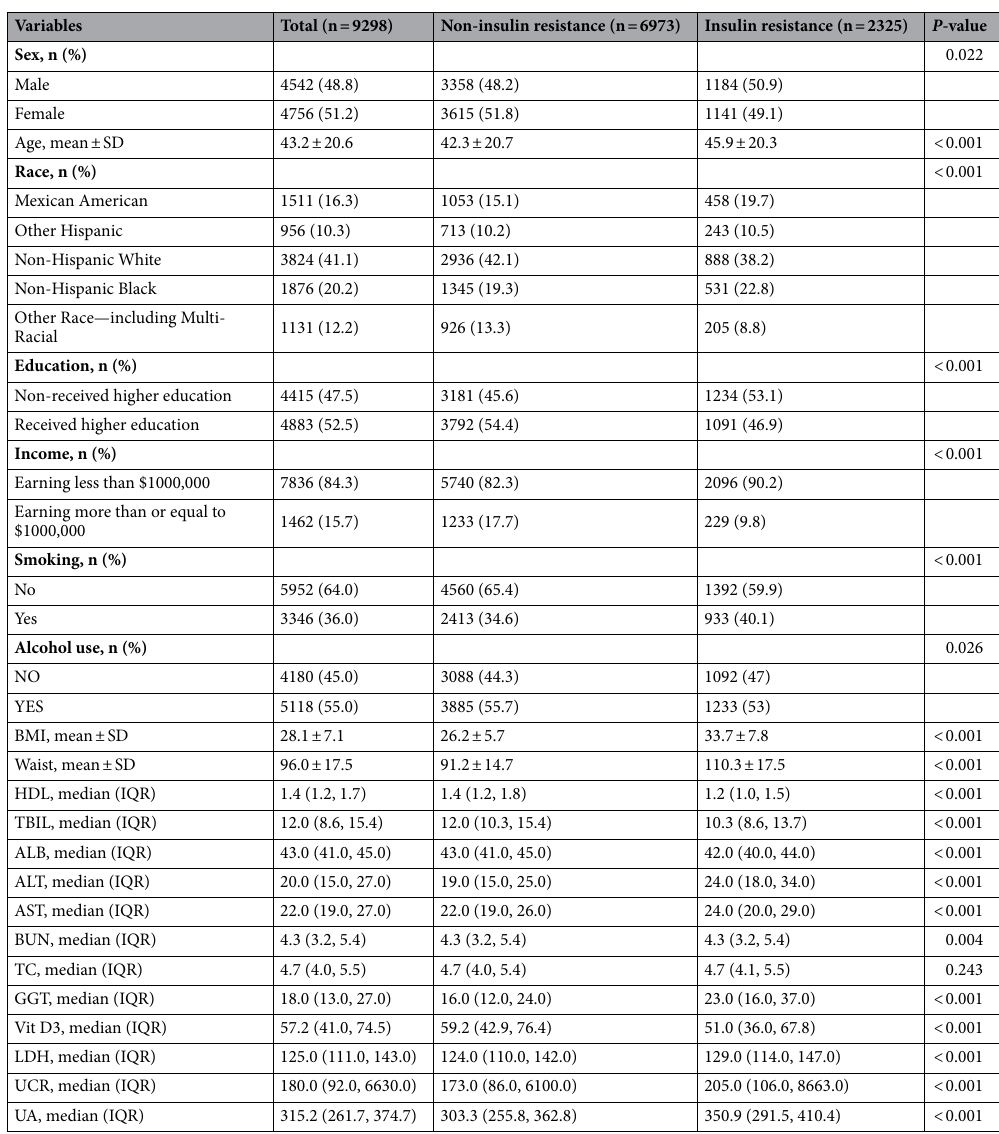
Table 1. Baseline characteristics of the study participants. BMI body mass index, HDL high density lipoproteinm, TBIL total bilirubin, ALB albumin, ALT alanine aminotransferase, AST